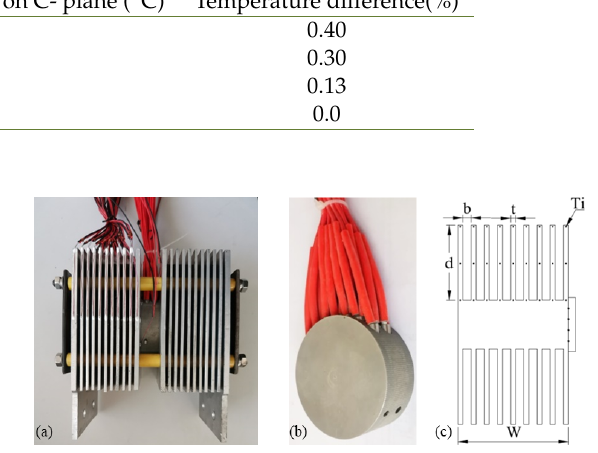
Fig. 7. The experimental model, heater, and places of thermocouples located: (a) the model; (b) heating block; (c) locations of